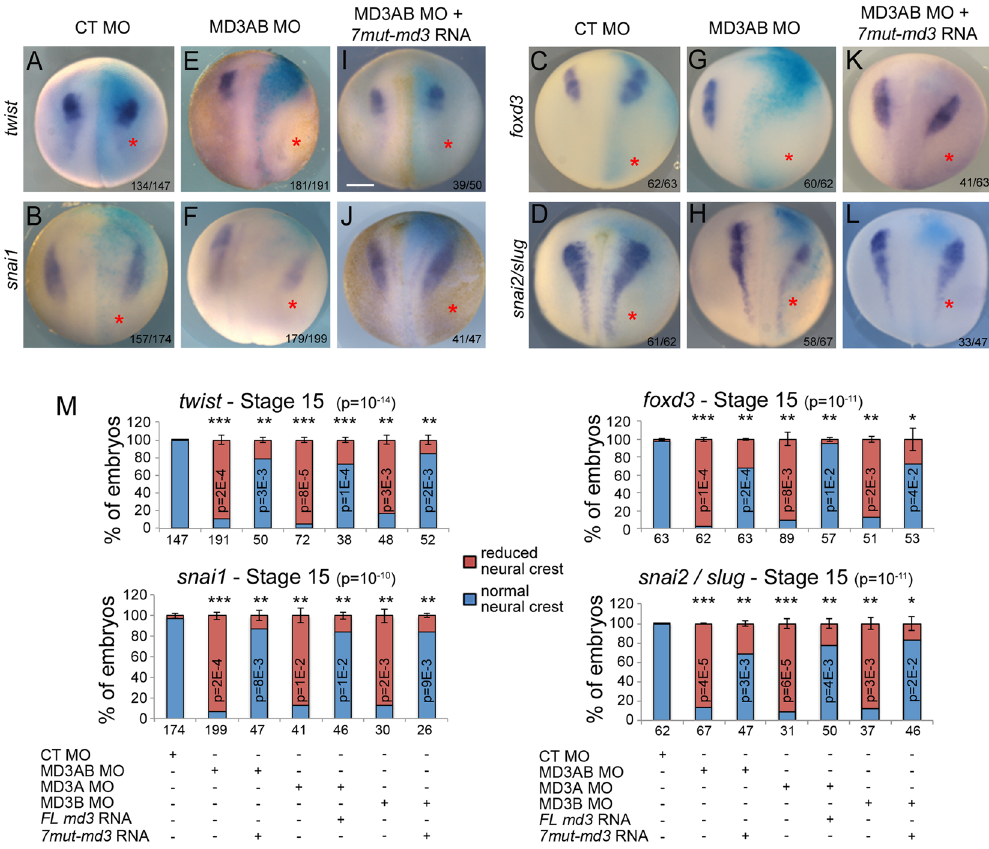
Figure 4. MarvelD3 is required for neural crest formation. Neural crest induction was analysed at stage 15 by WISH using probes against the neural crest markers twist , snai1 , foxd3 and snai2/slug , respectively, in control morpholino ( A – D ), MD3AB morpholinos ( E – H ) and embryos co-injected with MD3AB morpholino + 7mut- marveld3 RNA ( I – L ). The number of embryos analysed is indicated at the bottom right of each panel; red asterisk, injected side of the embryo with the light blue β -galactosidase staining; purple corresponds to the WISH staining; scale bar, 500 µ m. ( M ) Quantification of neural crest induction was performed for twist , snai1 , foxd3 and snai2/slug . ANOVA values are provided in parenthesis in the title of each graph. Student t-test p values and the number of embryos analysed are indicated under the graph. See Supplemental Fig. S1 for images of embryos injected with individual MD3A or MD3B morpholinos and corresponding rescue